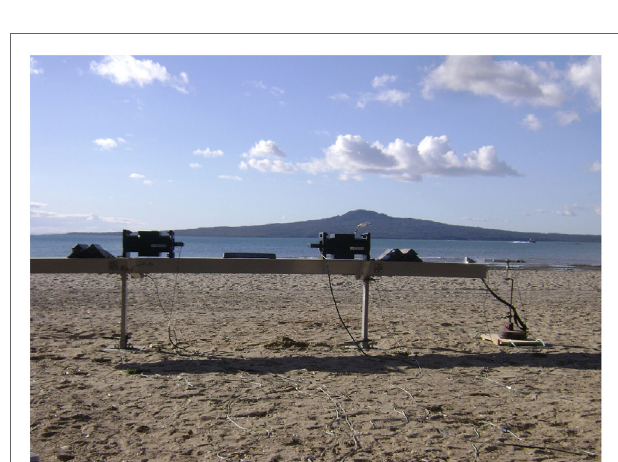
FigUre 3 | schematic drawing of the model